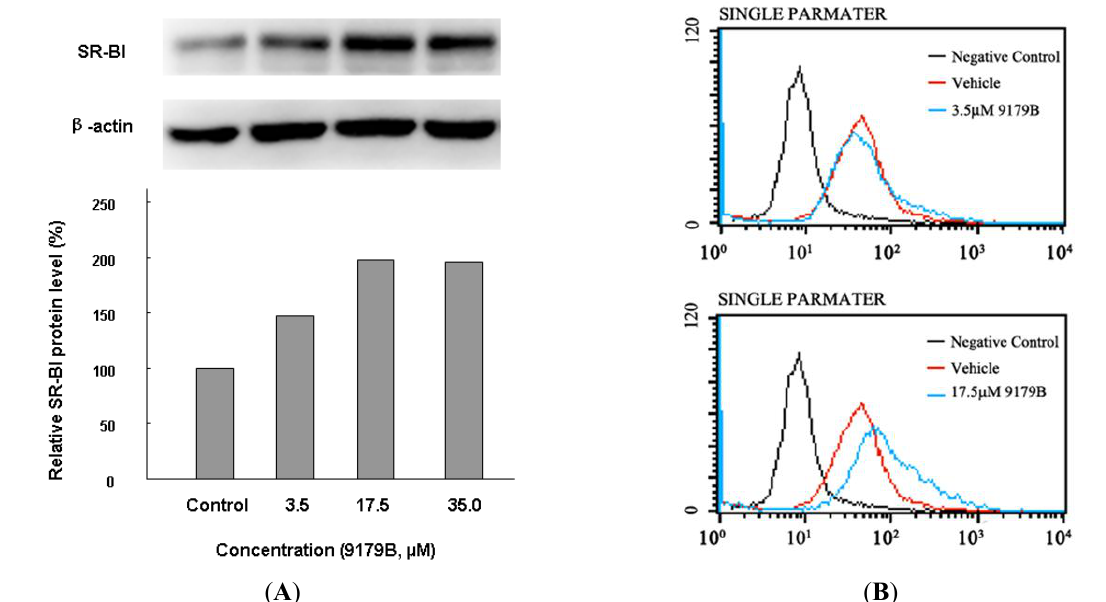
Figure 4. The effect of 9179B on the expression of SR-BI in RAW 264.7 cells and flow cytometry analysis of the uptake of DiI-HDL by RAW 264.7